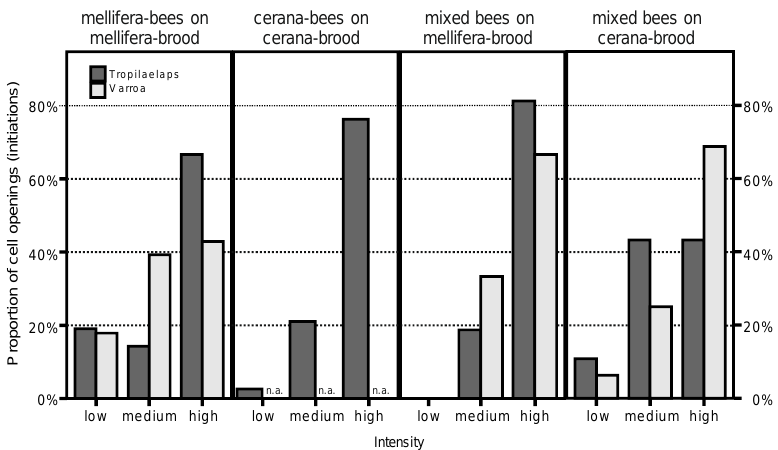
Figure 2. Survival of Tropilaelaps mercedesae - or Varroa destructor -infested brood by Apis mellifera worker bees.